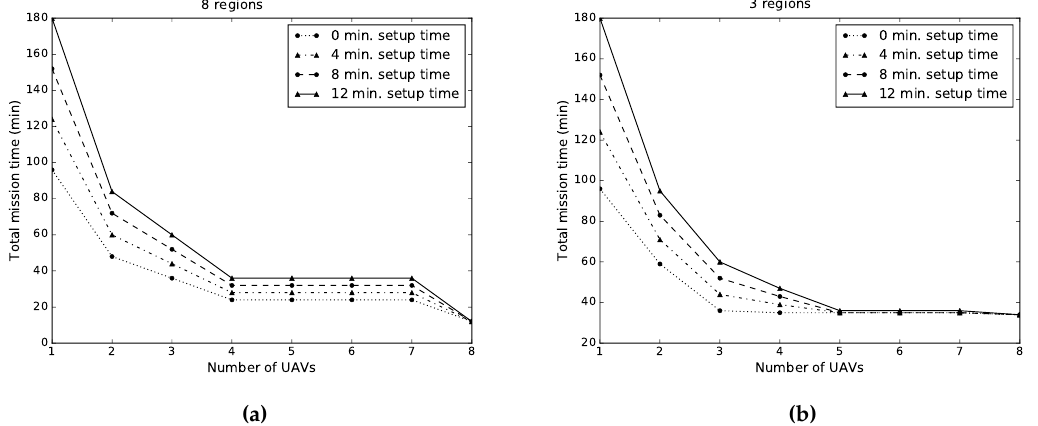
Figure 6. Simulation results that evaluate the total mission time in terms of the number of UAVs in the system, and of the system’s setup time. For all simulations we assume a ROI that has a constant size. ( a ) We divide the ROI in 8 regions. ( b ) We divide the ROI in 3